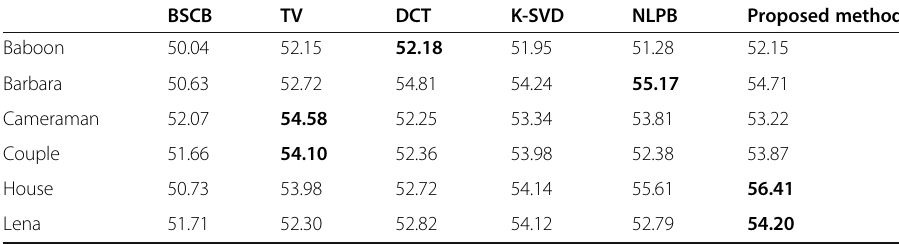
Table 5 The PSNR of each method for removing scratches (Unit: dB) BSCB